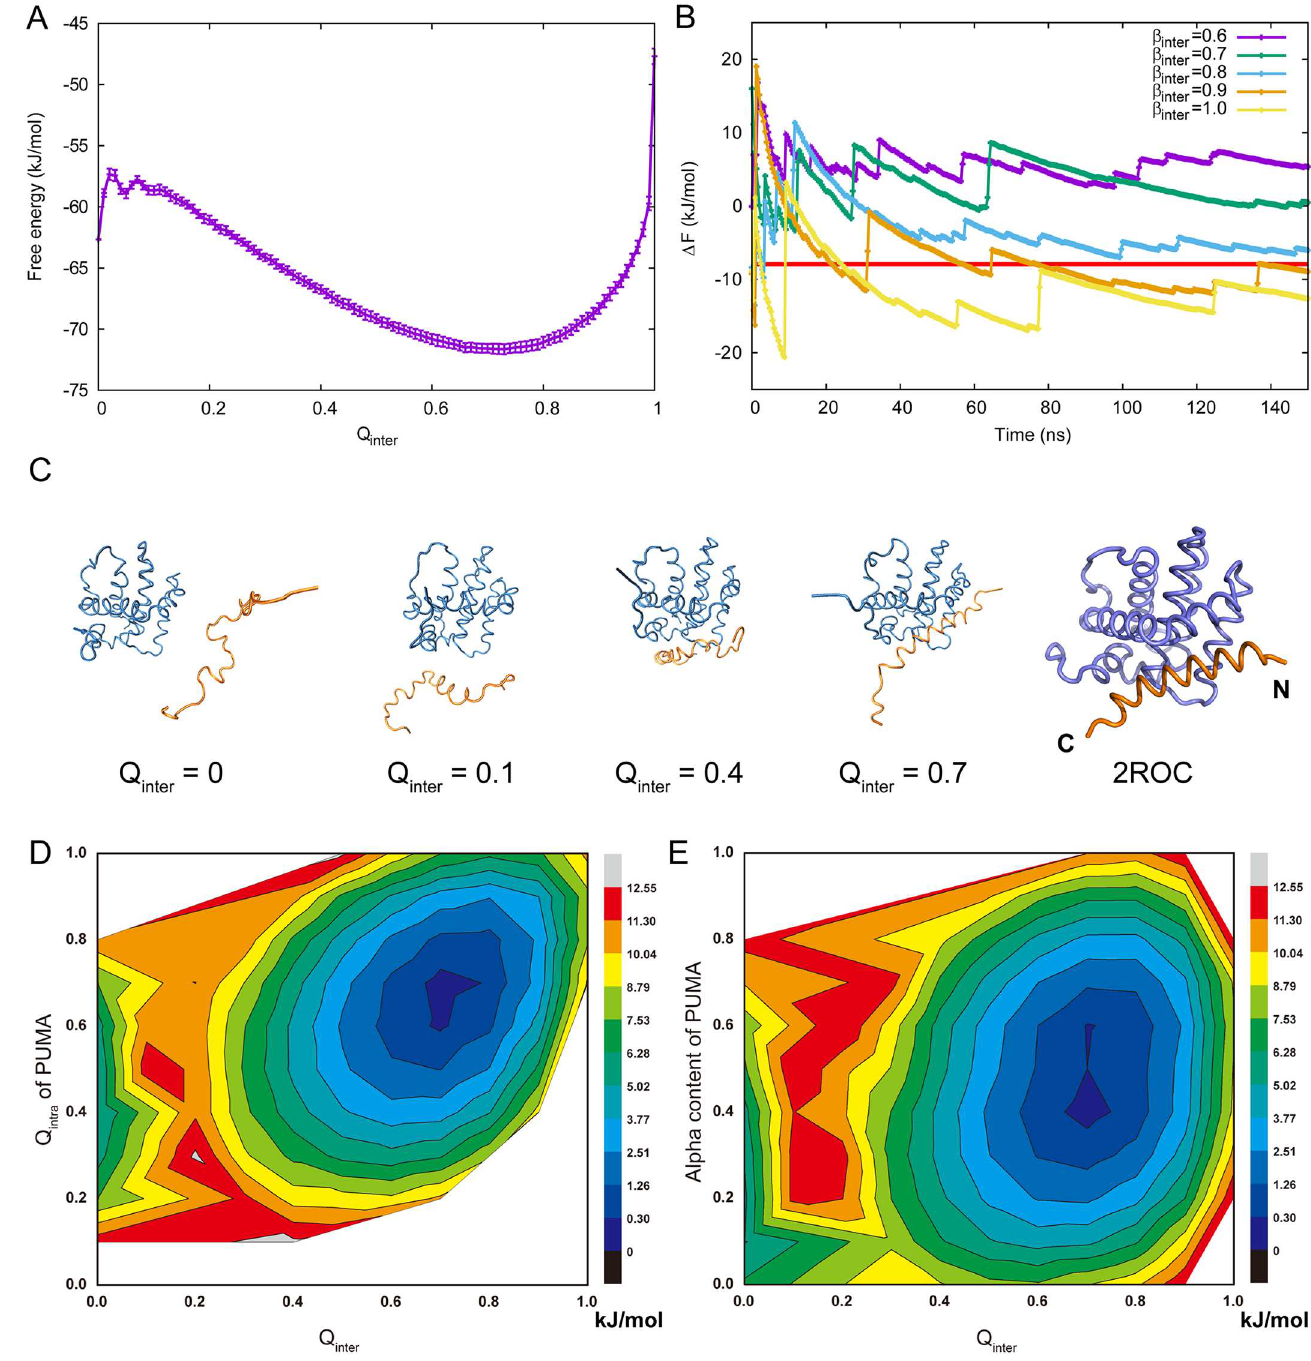
Fig 1. Parametercalibration and thermodynamic results. (A) Free energyprofiles of Mcl-1 and PUMA complex using fraction of intermolecular native contact betweenMcl-1 and PUMA ( Q inter ) as well as the standarddeviation.The standard deviationis calculatedwith the free energy data of the last 10 ns. (B) The convergence of bindingfree energy of Mcl-1 and PUMA with different β . The bindingfree energy was calculatedby the energy difference betweenbound state ( Q inter * 0.7) and unbound state ( Q inter = 0). (C) Representative frames throughoutthe bindingprocess. The bound state in our simulations is consistent with the NMR structure 2ROC (right). Mcl-1 and PUMA is depictedwith dark blue and orangetubes, respectively. (D) Free energy landscapeof Mcl-1 (cid:1) PUMA complex on both fraction of intermolecular native contact ( Q inter ) and fraction of intramolecular native contact of PUMA ( Q intra ). (E) Free energy landscapeof Mcl-1 and PUMA complex on both fraction of intermolecular native contact ( Q inter ) and helix content of PUMA. The helix content is calculatedusing torison angles.The z axis is the free energy(kJ/mol) calculatedby the probabilityusing WHAM [40] without the effect of bias